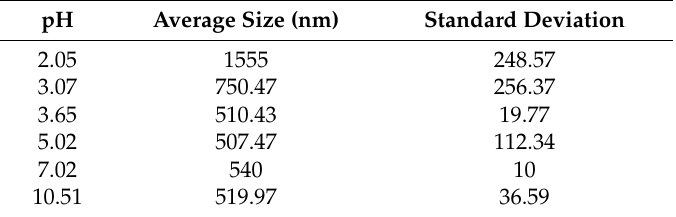
Figure A4. Zeta potential of GONP under varying pH levels, while maintaining a constant ion concentration of 10 mM NaCl. Table A1. Average size of GONP sheets, under varying pH levels, while maintaining a constant ion concentration of 10 mM NaCl.